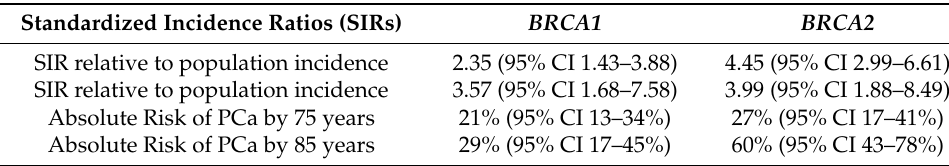
Table 2. Tabulated outcomes from prospective analysis by Nyberg et